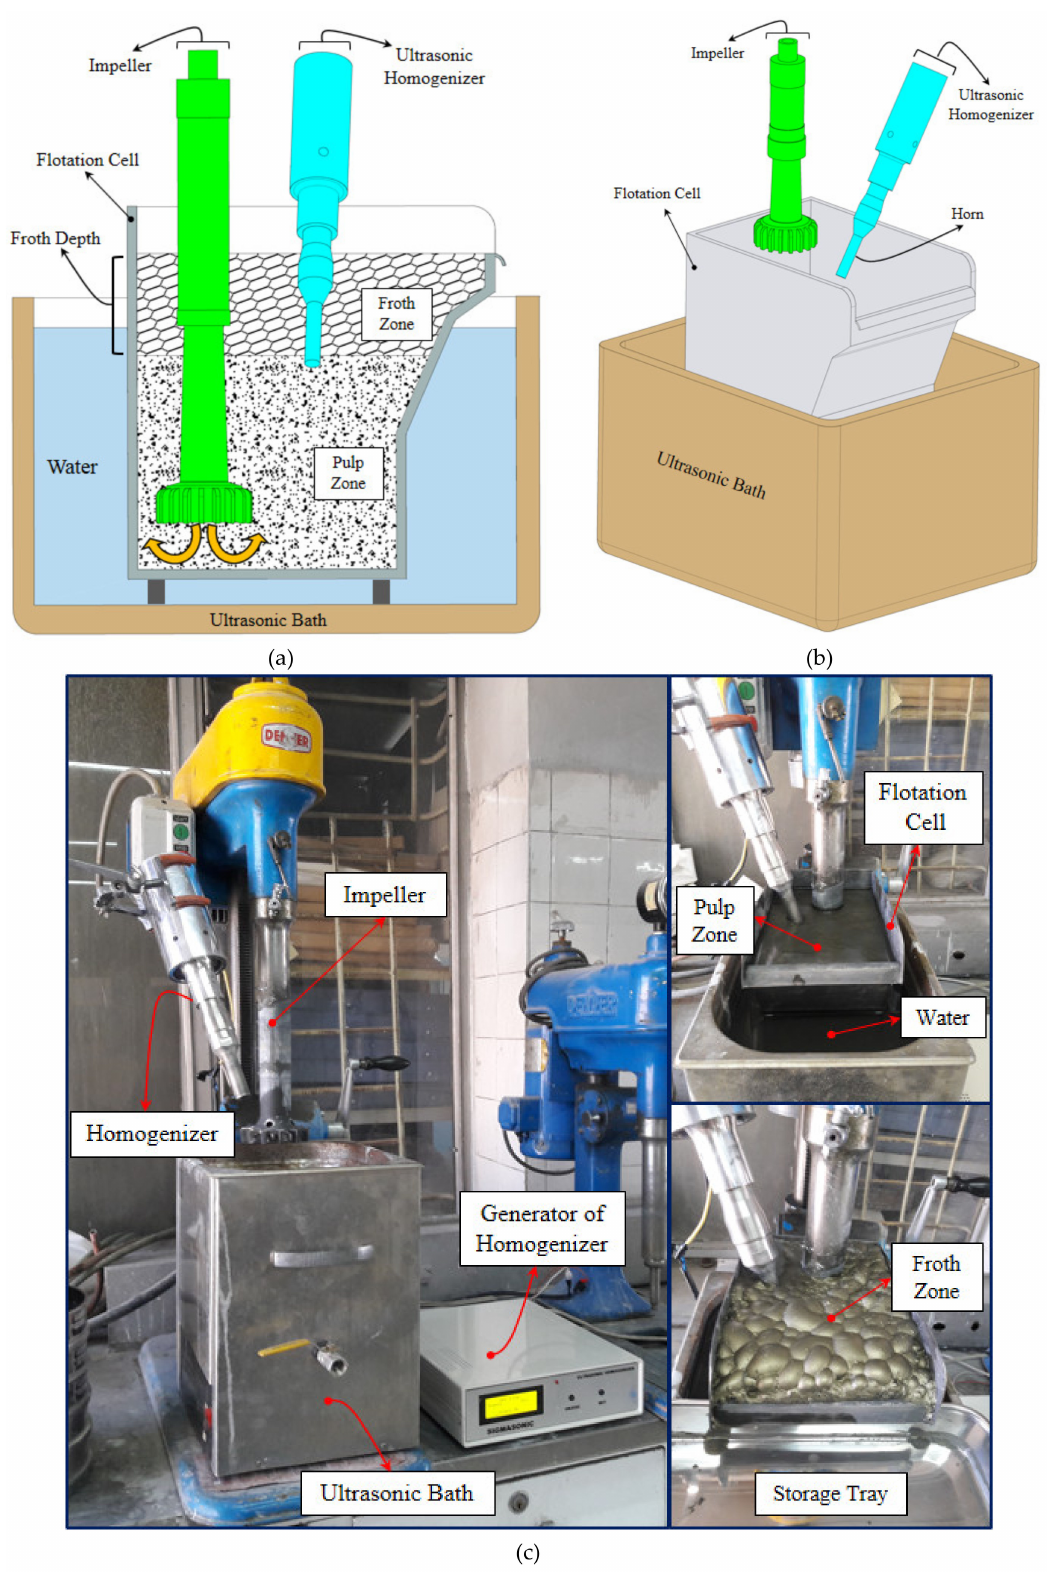
Figure 2. Schematic representation of the ( a ) 2D experimental setup for the flotation tests, ( b ) 3D overview of the flotation cell, and ( c ) laboratory design of the integrated cell with the ultrasonic bath and the